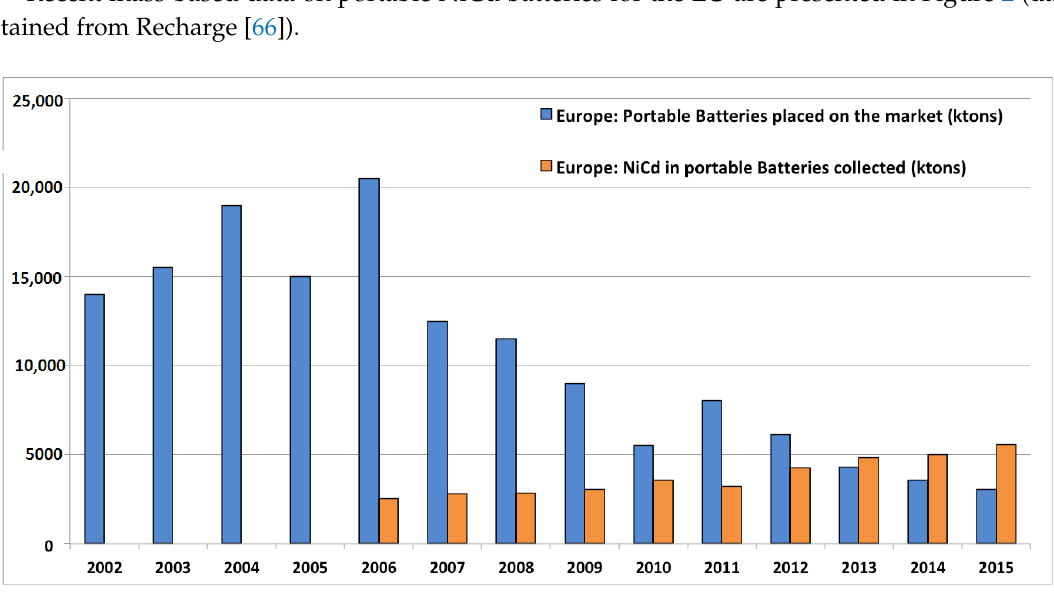
Figure 2. Portable NiCd batteries (Mg year −1 ) placed on market (blue columns) and taken back (orange columns) (Own graph, data obtained from Recharge [66]).